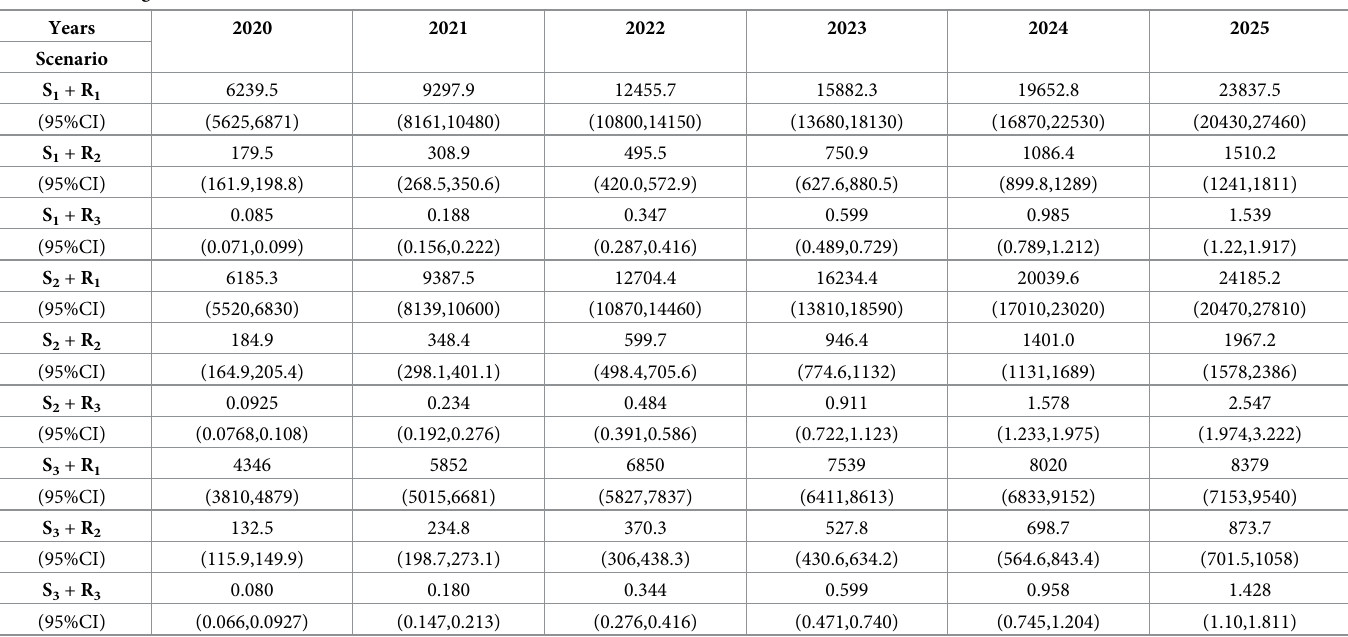
Table 6. New drug resistance infection under different